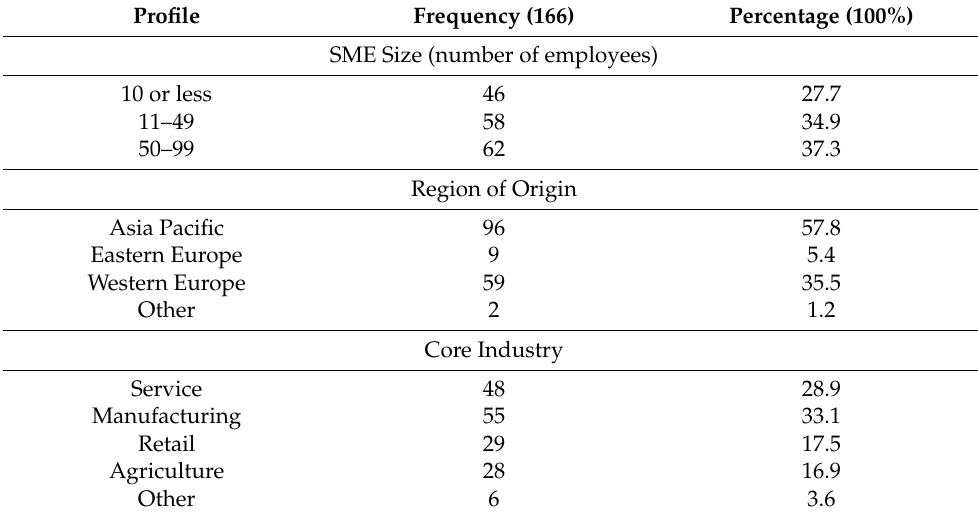
Table 1. Demographic